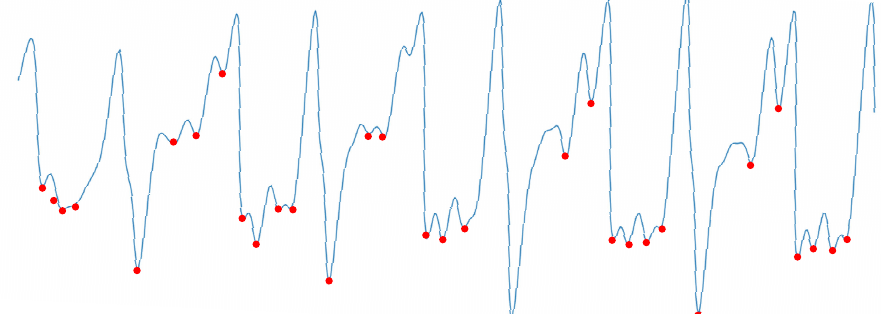
Figure 5. All minimal value points.